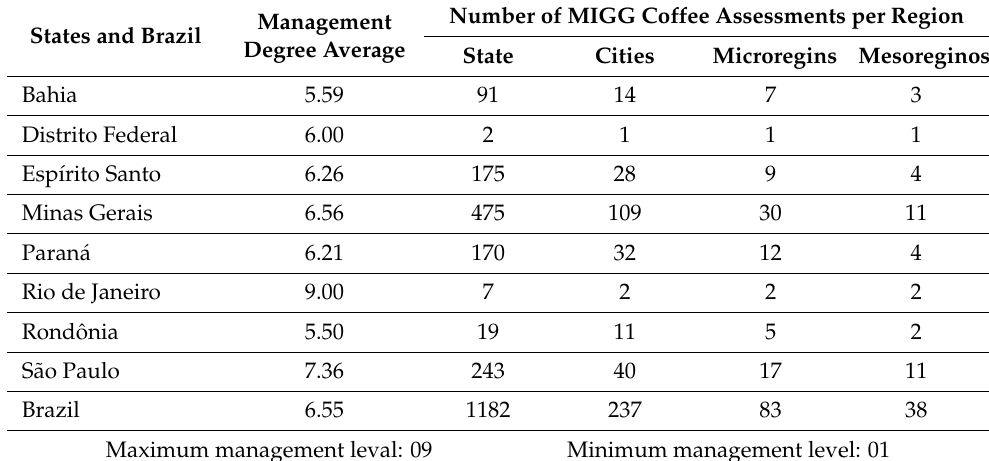
Table 3. Management degree in Brazilian coffee production according to MIGG assessment. States and